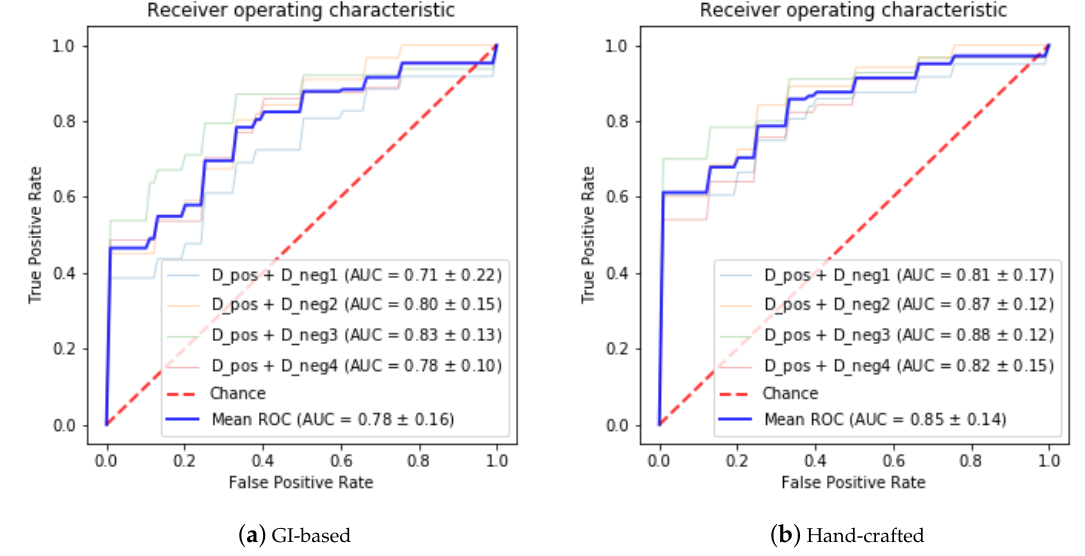
Figure 4. Receiver operating characteristic curves using Logistic